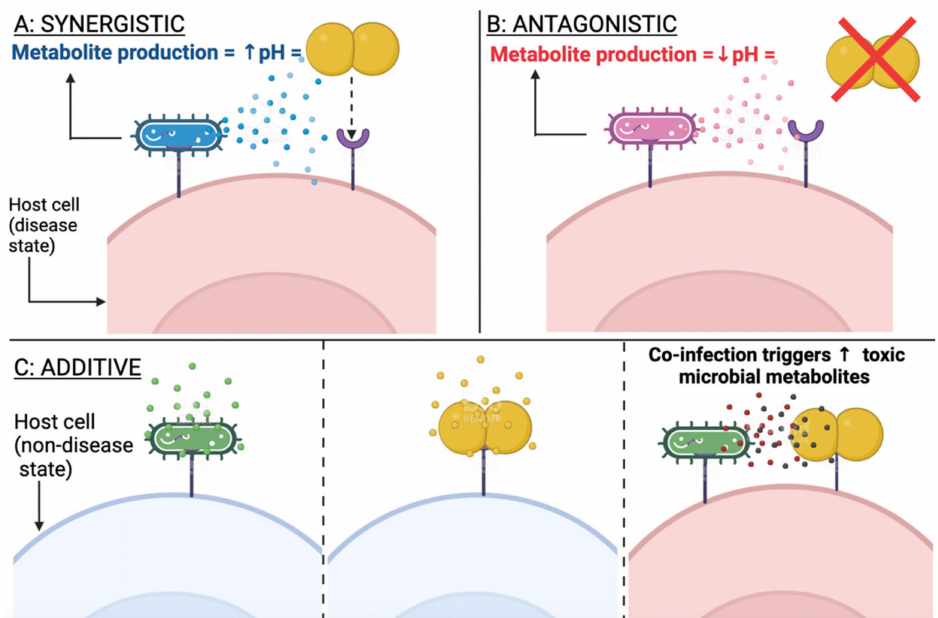
Figure 2. Examples of some interactions that can take place between microbes of different species (represented by different colours and shapes). ( A )—colonisation of the first microbe compromises the host’s immune system, and creates an environment (e.g., increase in pH) that favours coloni- sation of the second microbe; ( B )—colonisation of the first microbe creates an environment (e.g., product fermentation leading to pH decrease) that prevents colonisation of the second microbe; ( C )—colonisation of two microbes on their own has no pathogenic effect, but cause disease when they